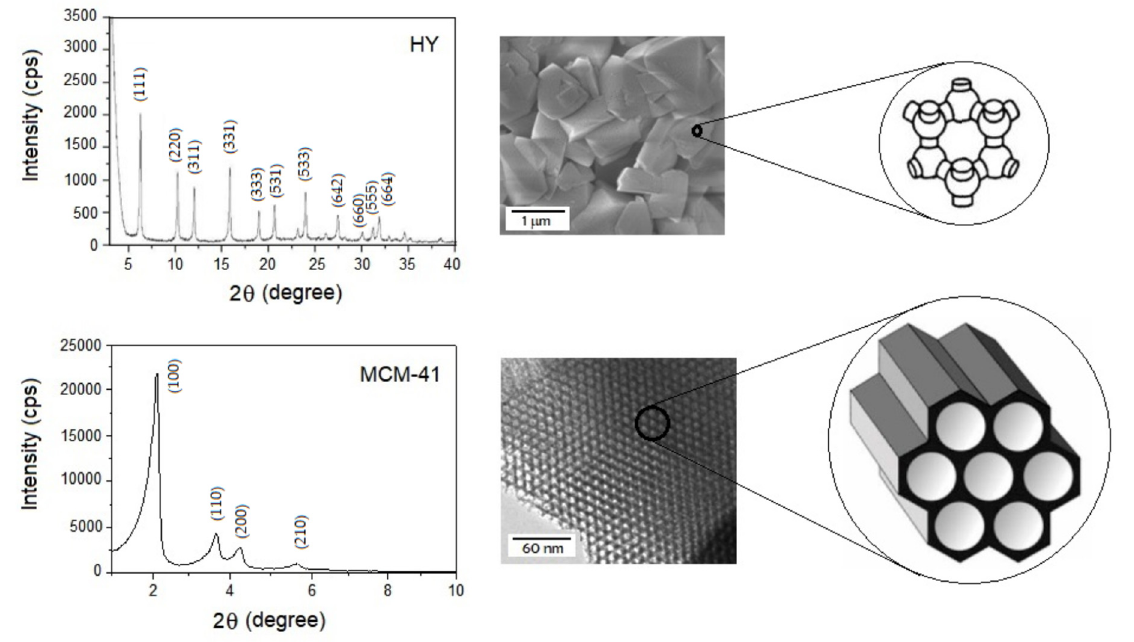
Figure 2. X-ray diffractogram and scanning electron micrograph of zeolite HY, and its transmission for MCM-41, with micro and mesopores systems, respectively.